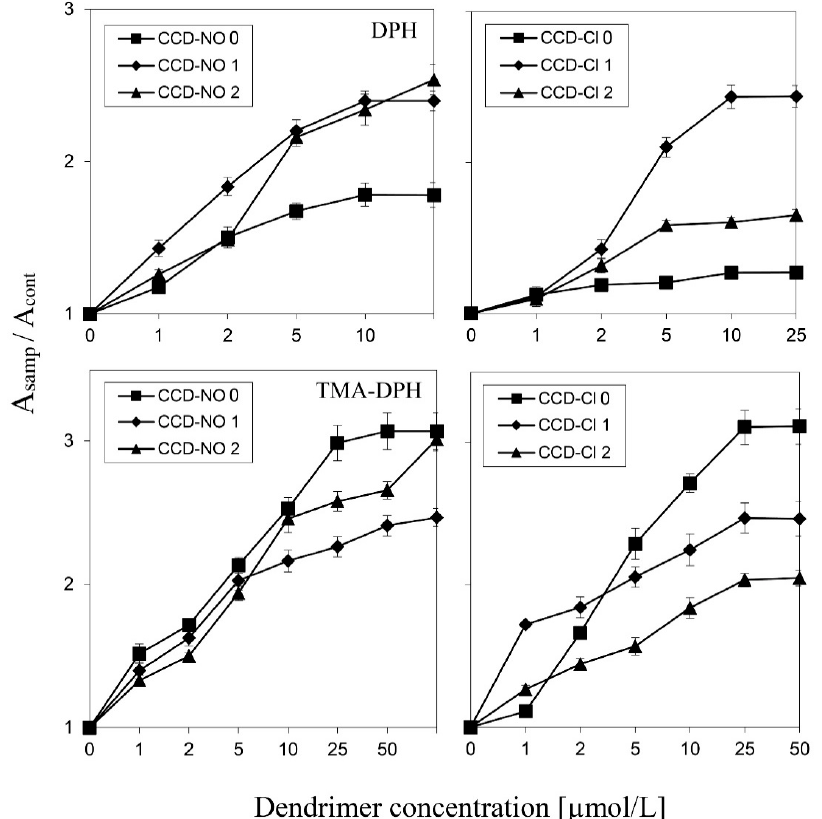
Figure 5. Changes in fluorescence anisotropy of DPH (top panels) and TMA-DPH (bottom panels) of erythrocyte membranes incubated with copper metallodendrimers at rising concentrations from 1 to 70 µmol/L. PBS buffer, pH 7.4, 37°C. CCD-Cl: left panels, CCD-NO: right panels. The values are the mean ± SD, n = 3.